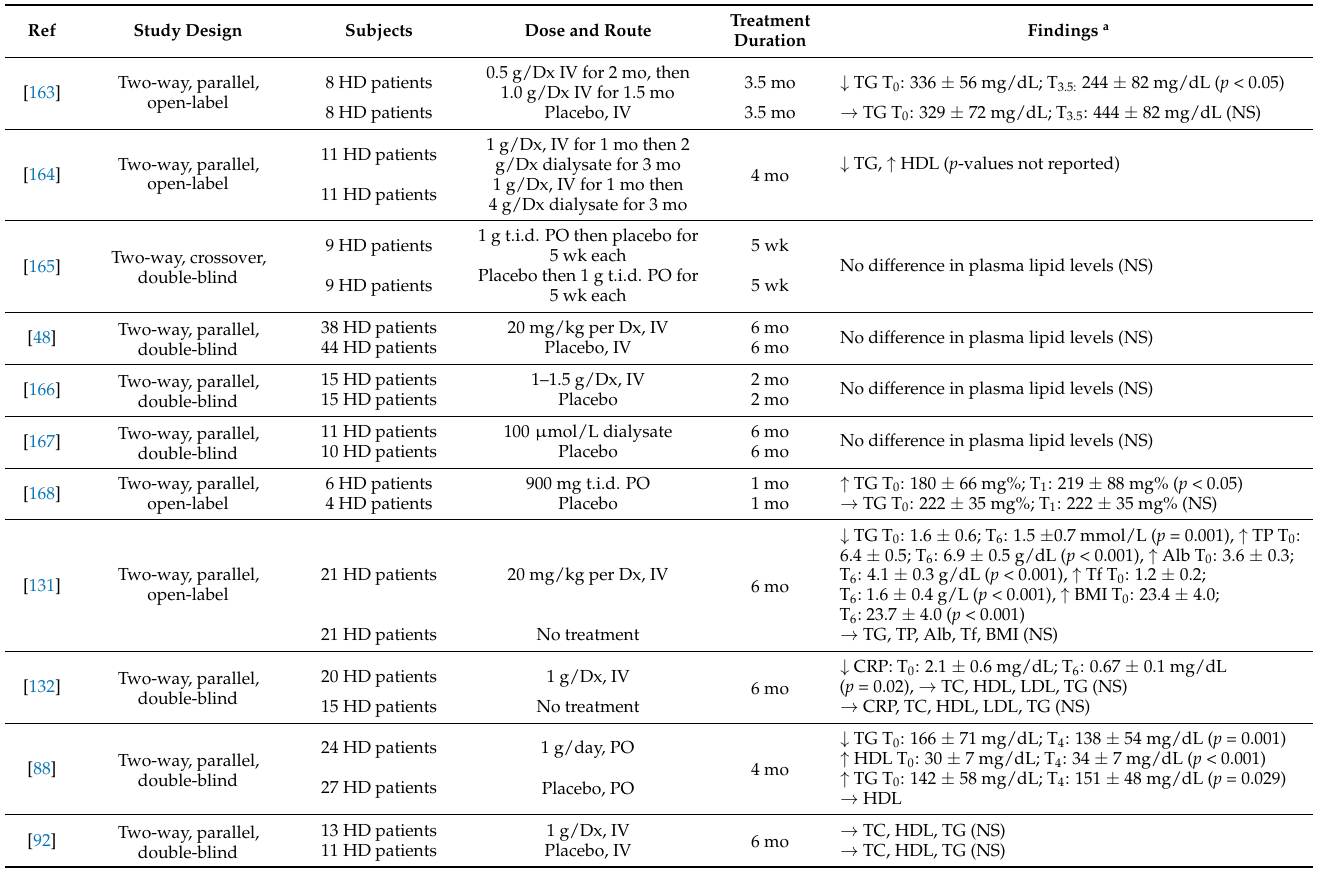
Table 4. Studies of the effect of levocarnitine on lipid profiles and inflammatory-related parameters in dialysis patients.